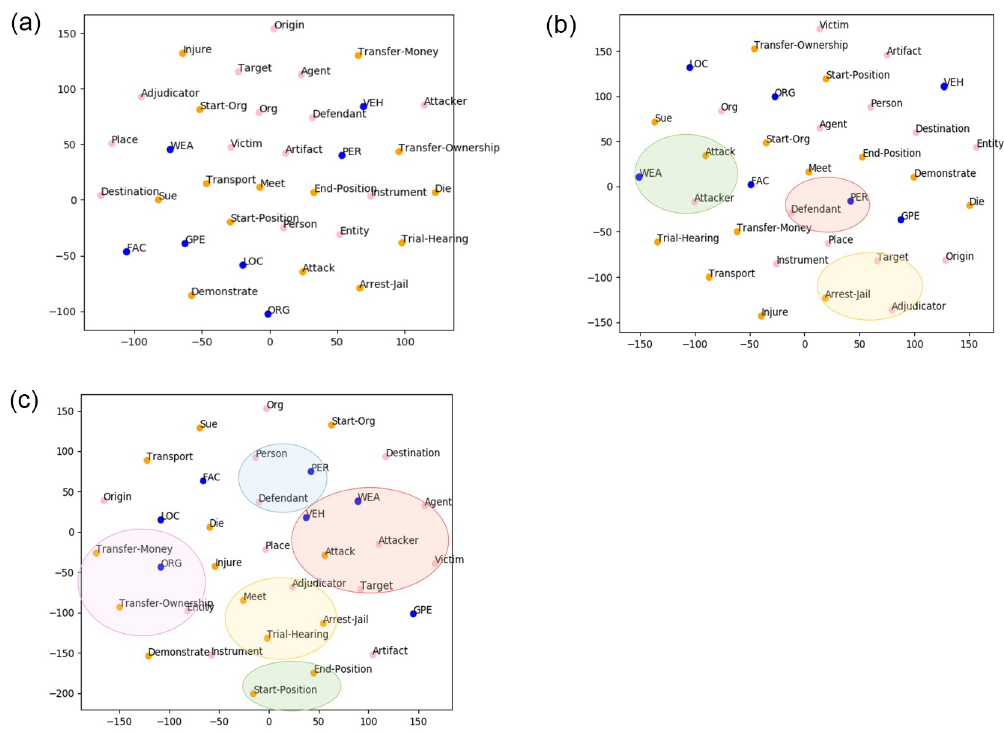
Fig 3. t-SNE plot of joint label embeddings of entities, triggers and argument roles with varying numbers of training epochs. (a) 3 epochs, (b) 10 epochs, and (c) 40 epochs.